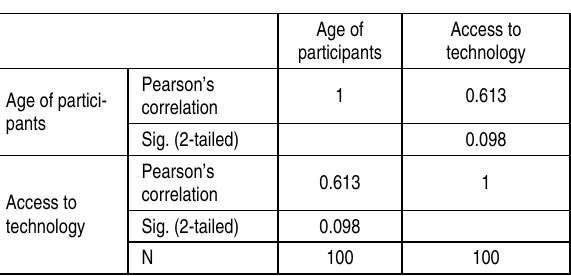
Access to technology